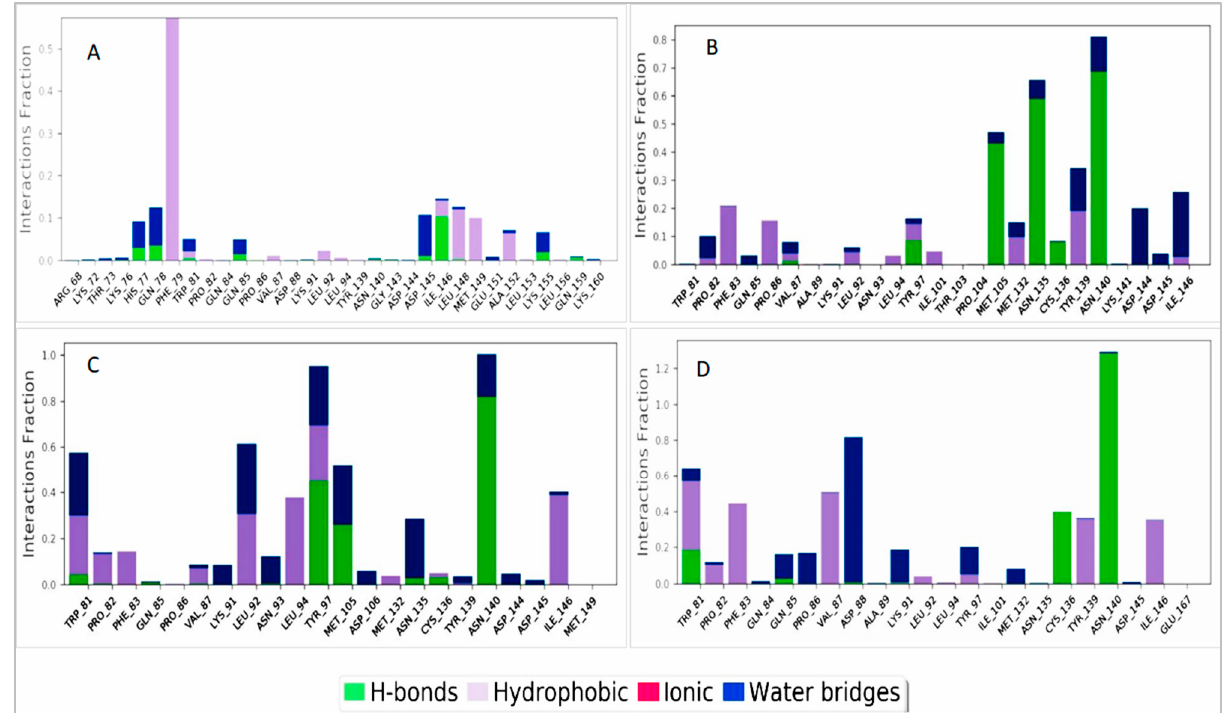
Figure 10. Protein–ligand interactions for the selected compounds: ( A ) ZINC4104882, ( B ) ZINC2509501, ( C ) ZINC2566088, and ( D ) ZINC1615112.